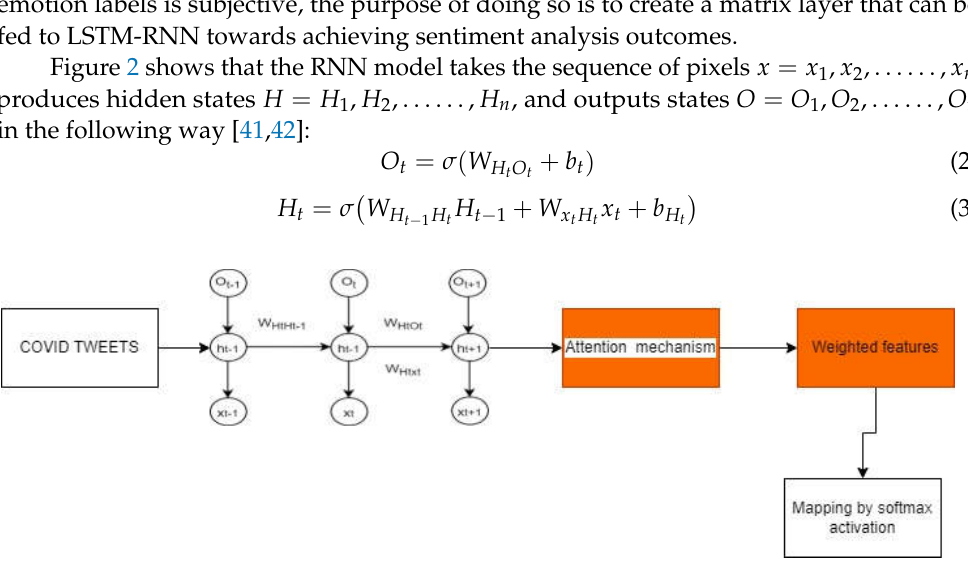
Figure 2. A graphical model of RNN and proposed